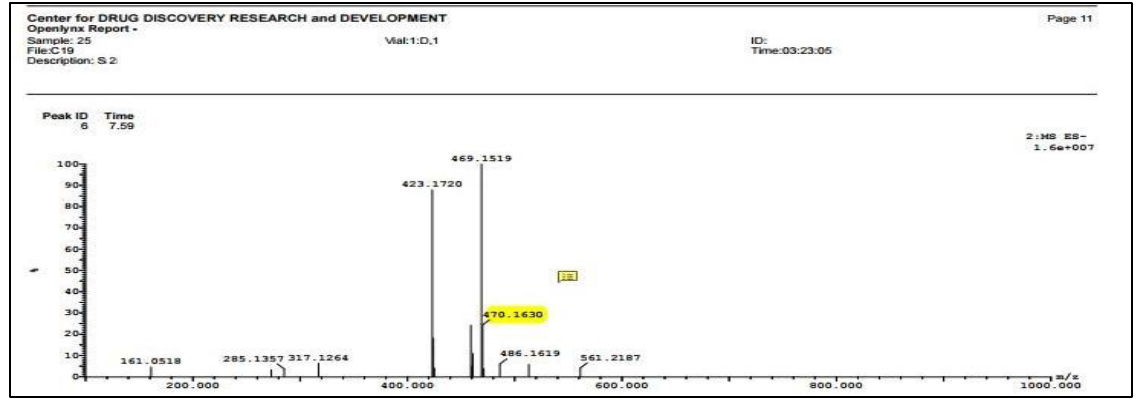
Figure 9. Mass 1 of isolated aq1 compound in negative ion mode showing M and M-H with adduct formation. Table 3 .UPLC-ESI-MS/MS of the isolated compounds.